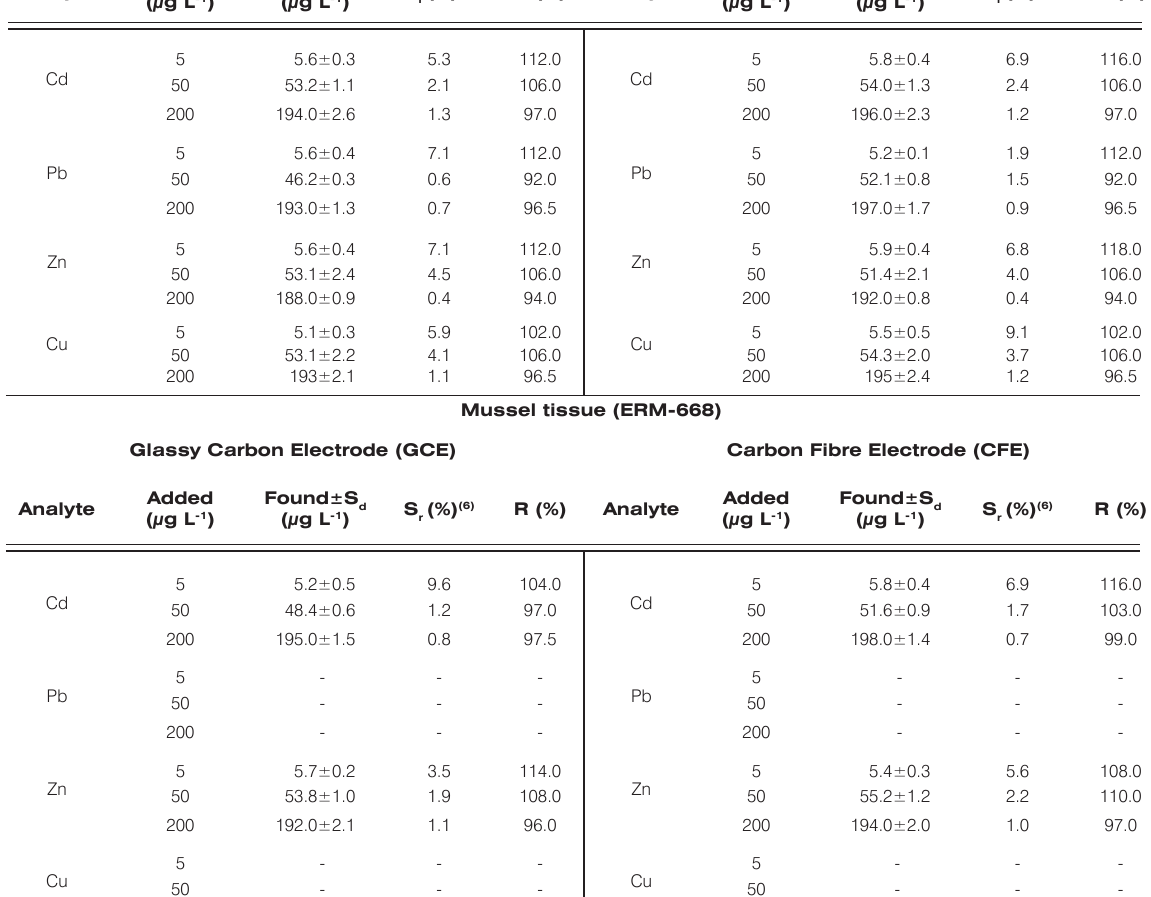
SWASV signals for each metal are well-defined and linear with concentration at the low μ g L -1 level.